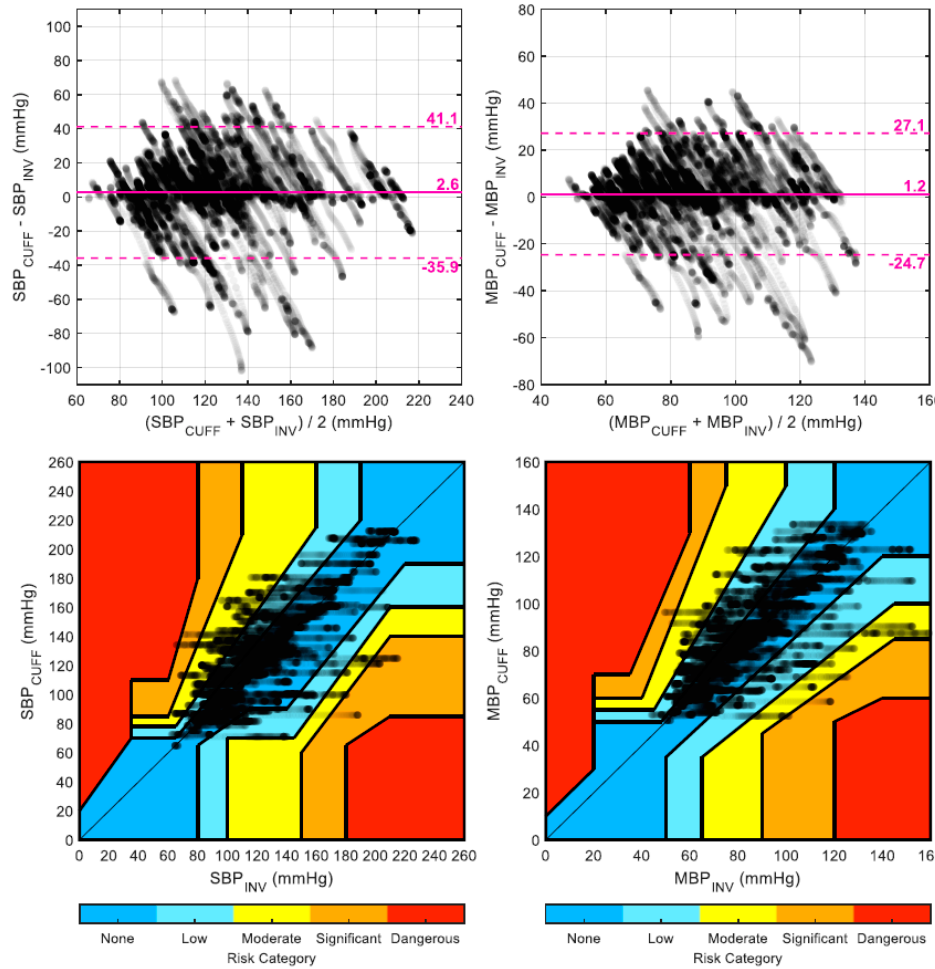
Figure 3. Bland-Altman plots and error grid analysis plots for BP CUFF (SBP/MBP).